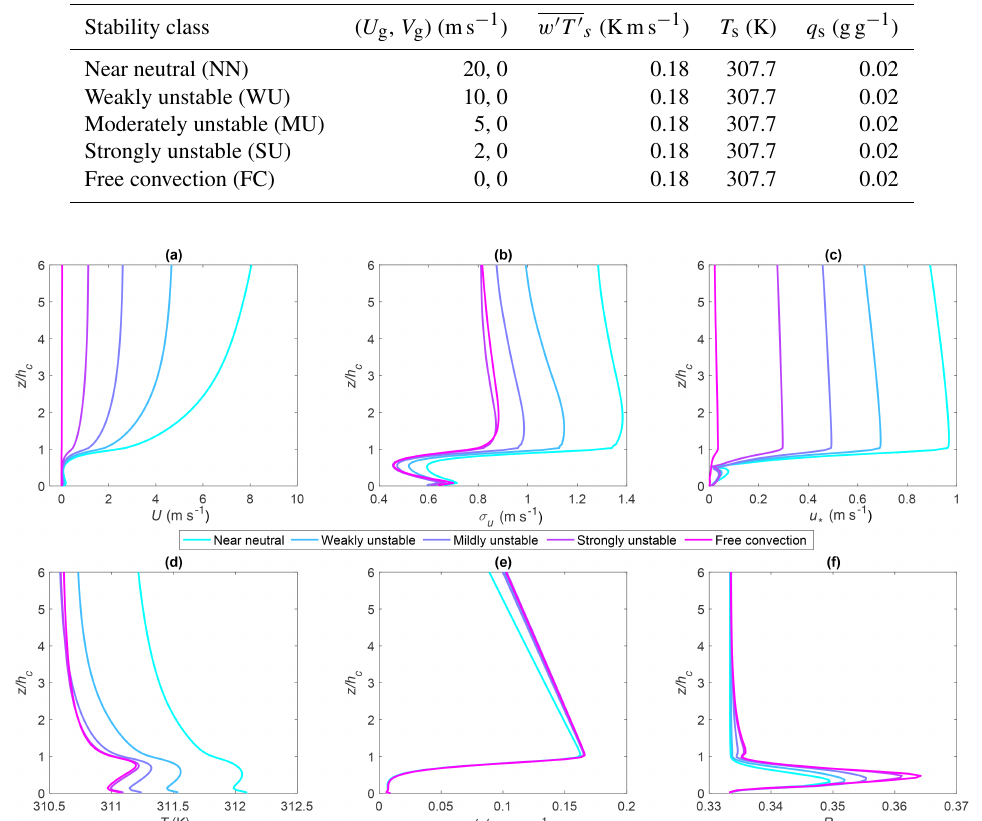
Table 2. Parameters to drive the simulations for five different instability classes, namely, near neutral (NN), weakly unstable (WU), mod- erately unstable (MU), strongly unstable (SU), and free convection (FC), are similar to Patton et al. (2015). U g and V g denote geostrophic wind speeds, w (cid:48) T (cid:48) toc denotes canopy top surface sensible heat flux, T s denotes ground surface potential temperature, and q s denotes specific humidity at the ground surface.